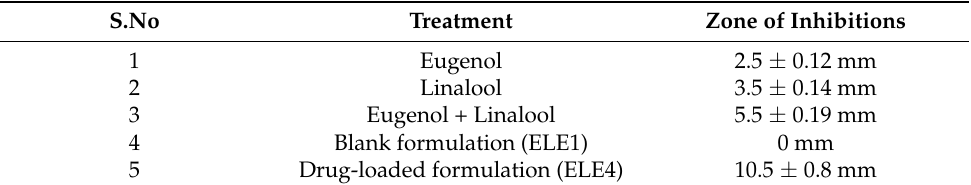
Table 6. Effect of linalool, eugenol and linalool-eugenol emulgel on growth of T. ruburum .